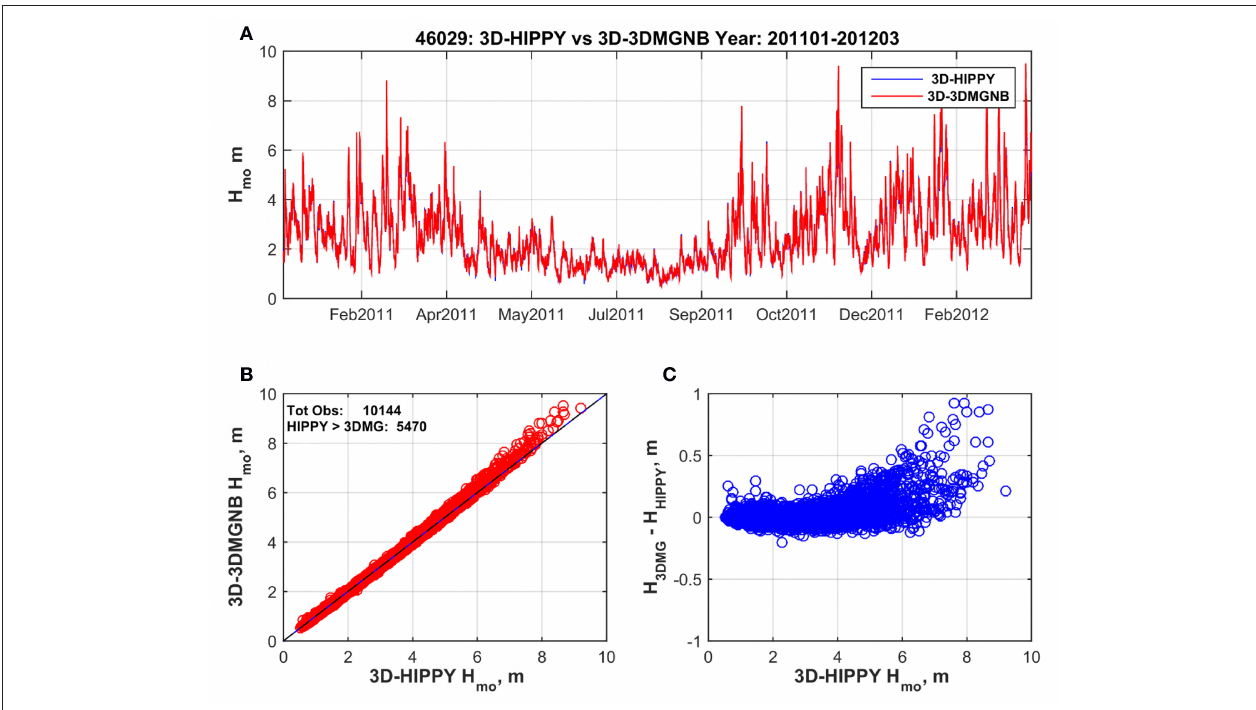
FIGURE 6 | Differences in H s for two sensors, a strapped-down 3DMG accelerometer, and a gimballed HIPPY sensor, mounted on the same buoy NDBC buoy 46029 (Columbia River Bar, Oregon) in a water depth of 134 m. (A) Shows time series from january 2011 to February 2012. (B) Shows 3DMGNB against HIPPY. (C) Shows the difference between the two as a function of wave